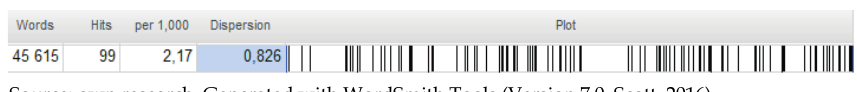
Figure 4. The dispersion plot of the expression “so it goes” in Vonnegut’s Slaughterhouse